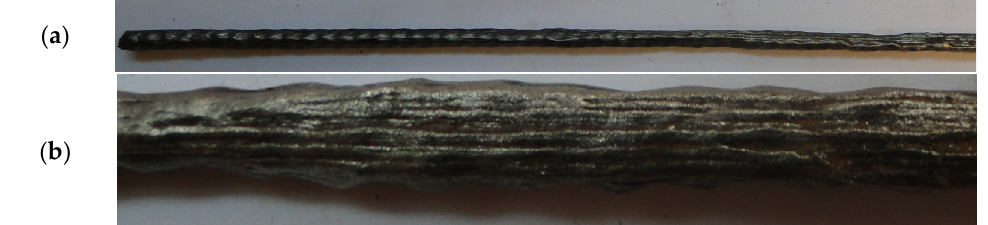
Figure 5. The sample ϕ 6 (B500 B) after corrosion in corrosion chamber: ( a ) whole sample, ( b ) de- tail.